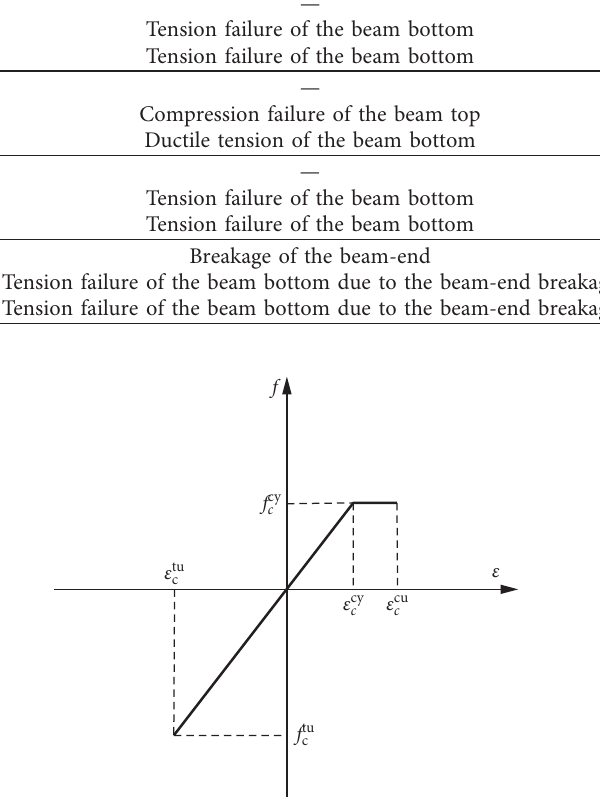
Figure 14: Constitutive model of the stress-strain relationship of the glulam